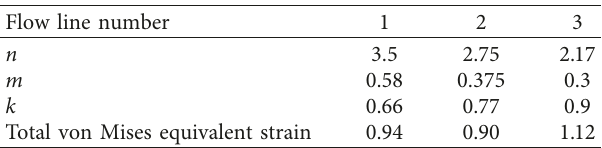
Figure 2: Experimental flow lines (circles, taken from reference [4]) for NECAP of Al, p / c � 2, together with the fits obtained by the newly proposed flow line function (a) (equation (3)) and by the previous function (b) (equation (2)) identified by continuous lines. The plastic deformation zone is displayed by dash-dot lines, which is limited by the zone situated between 1% and 99% of the total strain in one pass. The dotted line identifies the position of the maximum strain rate. Table 1: The parameter values and the total von Mises strains for the three flow lines shown in Figure